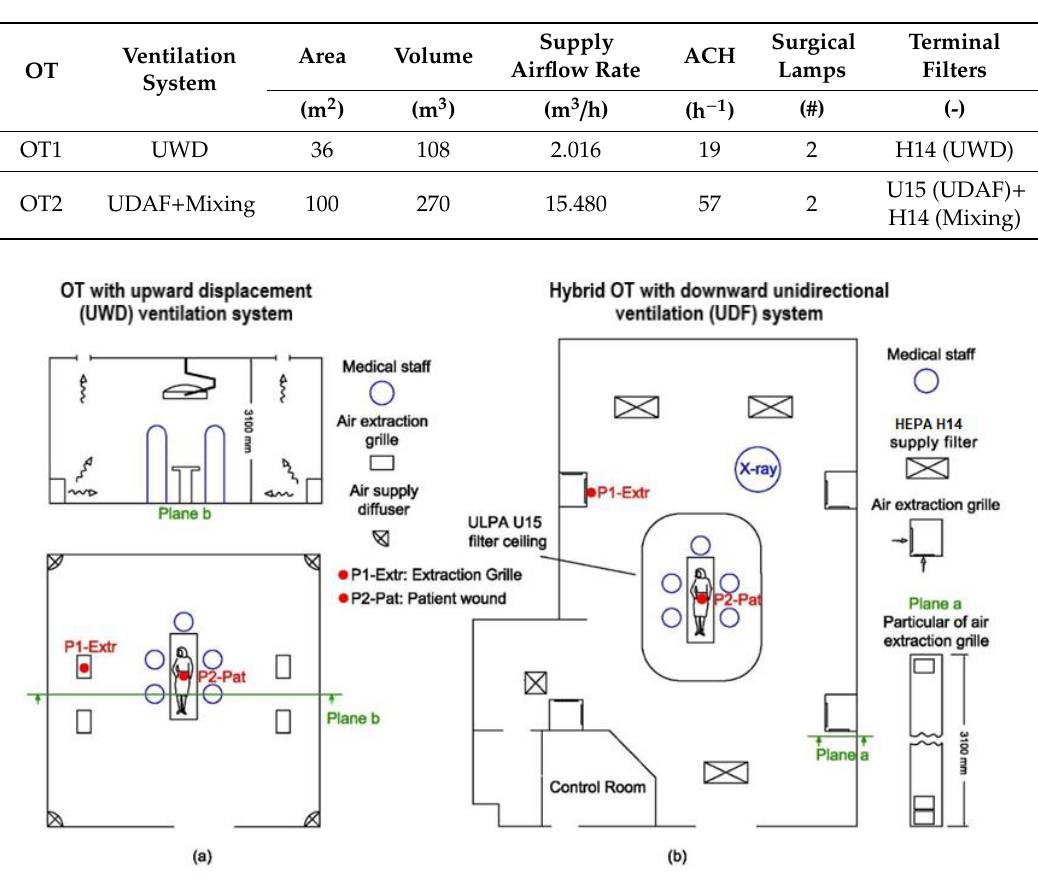
Figure 1. Operating theatres layout and sampling probe position: ( a ) OT1 with UWD; ( b ) OT2, Hybrid OT (UDAF+Mixing).